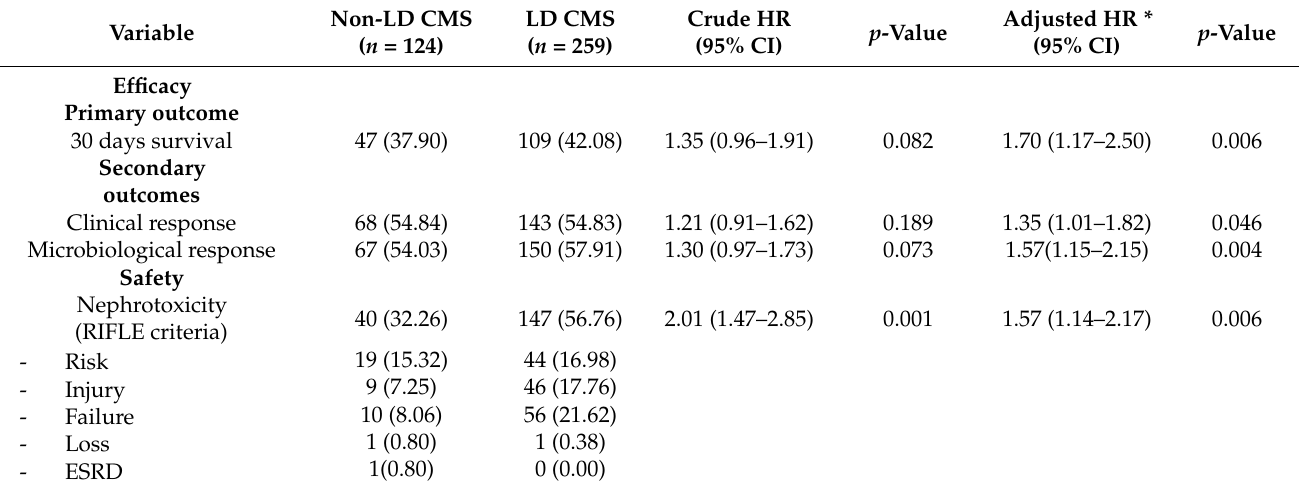
Table 2. Cox regression analysis of outcomes for critically ill patients receiving LD CMS and non-LD CMS therapy ( n = 383).